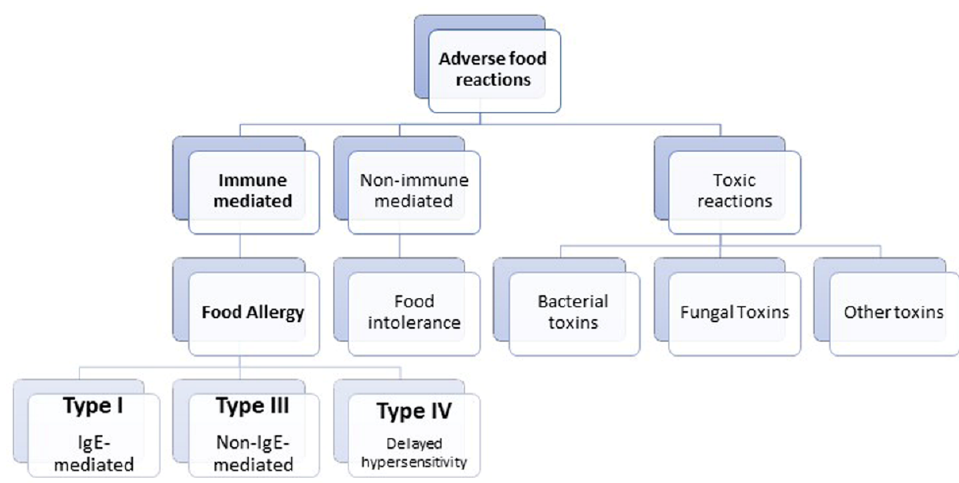
Scheme 1. Schematic representation of the classification of adverse food reactions.